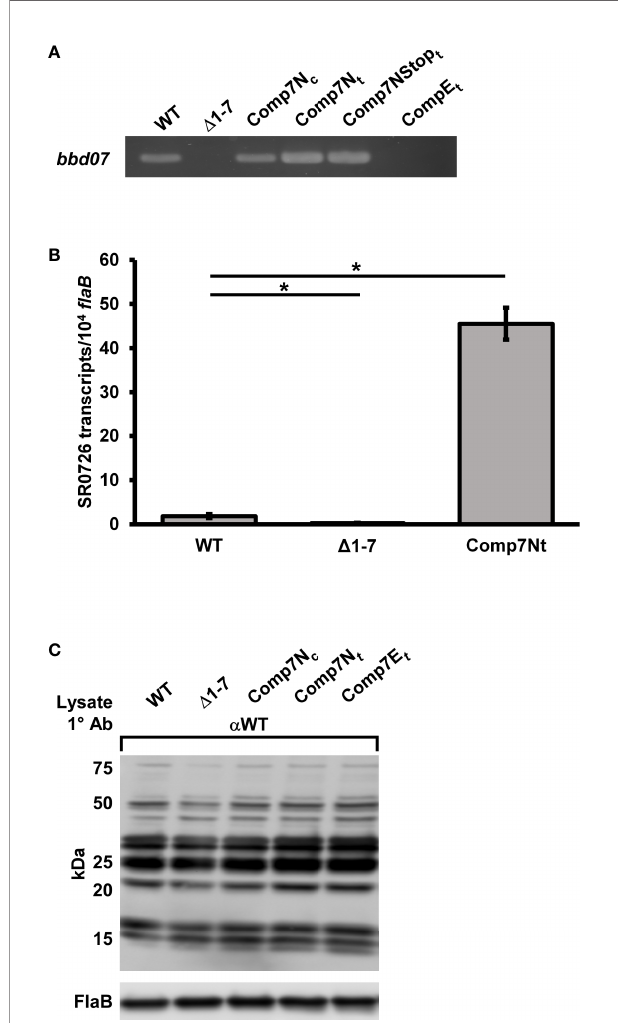
FIGURE 2 | In trans complementation of bbd07 results in elevated SR0726 transcription that does not alter in vitro antigen expression. (A) PCR veri fi cations of successful in trans complementation using P931/P932. (B) Assessment of SR0726 transcript levels by indicated strains in vitro via qRT-PCR. Triplicate cultures were grown to late log-phase (10 8 spirochetes mL -1 ). Reactions were performed in duplex with primers for SR0726 (P1001/ P1003) and fl ab (P411/P412). Data bars indicate the average number of SR0726 copies per 10 4 fl aB copies. Data from negative control reactions using D 1-7 cDNA is included to illustrate background signal in the assay. Students t-test was performed to assess signi fi cance of the differences in SR0726 transcription between each recombinant strain and wild type ( P < 0.05), and error bars indicate SEM among the biological replicates (n = 3). (C) Indicated strains were grown in vitro in triplicate under the same conditions used for in vitro SR0726 transcript quanti fi cation. Bacterial lysates (10 9 cells per lane) were Western blotted with serum collected from C3H mice infected with wild type for 28 days. FlaB protein from these lysates was probed with polyclonal anti-FlaB antibodies as a loading control. Approximate molecular weights are indicated to the left. Asterisk indicates signi fi cant difference in SR0726 transcription levels between indicated strains by Students